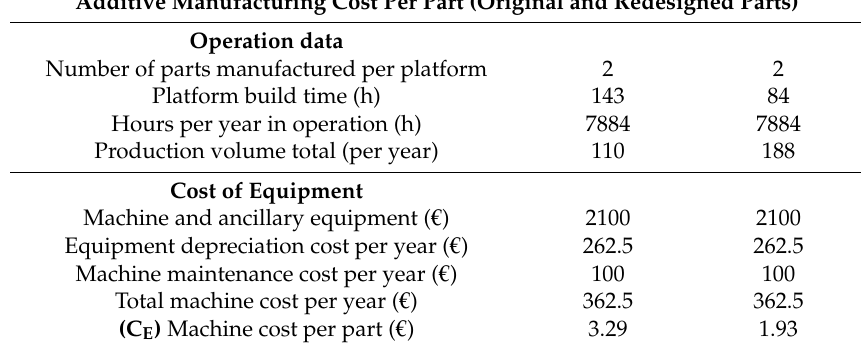
Table 8. AM costs assessment for the redesigned product.